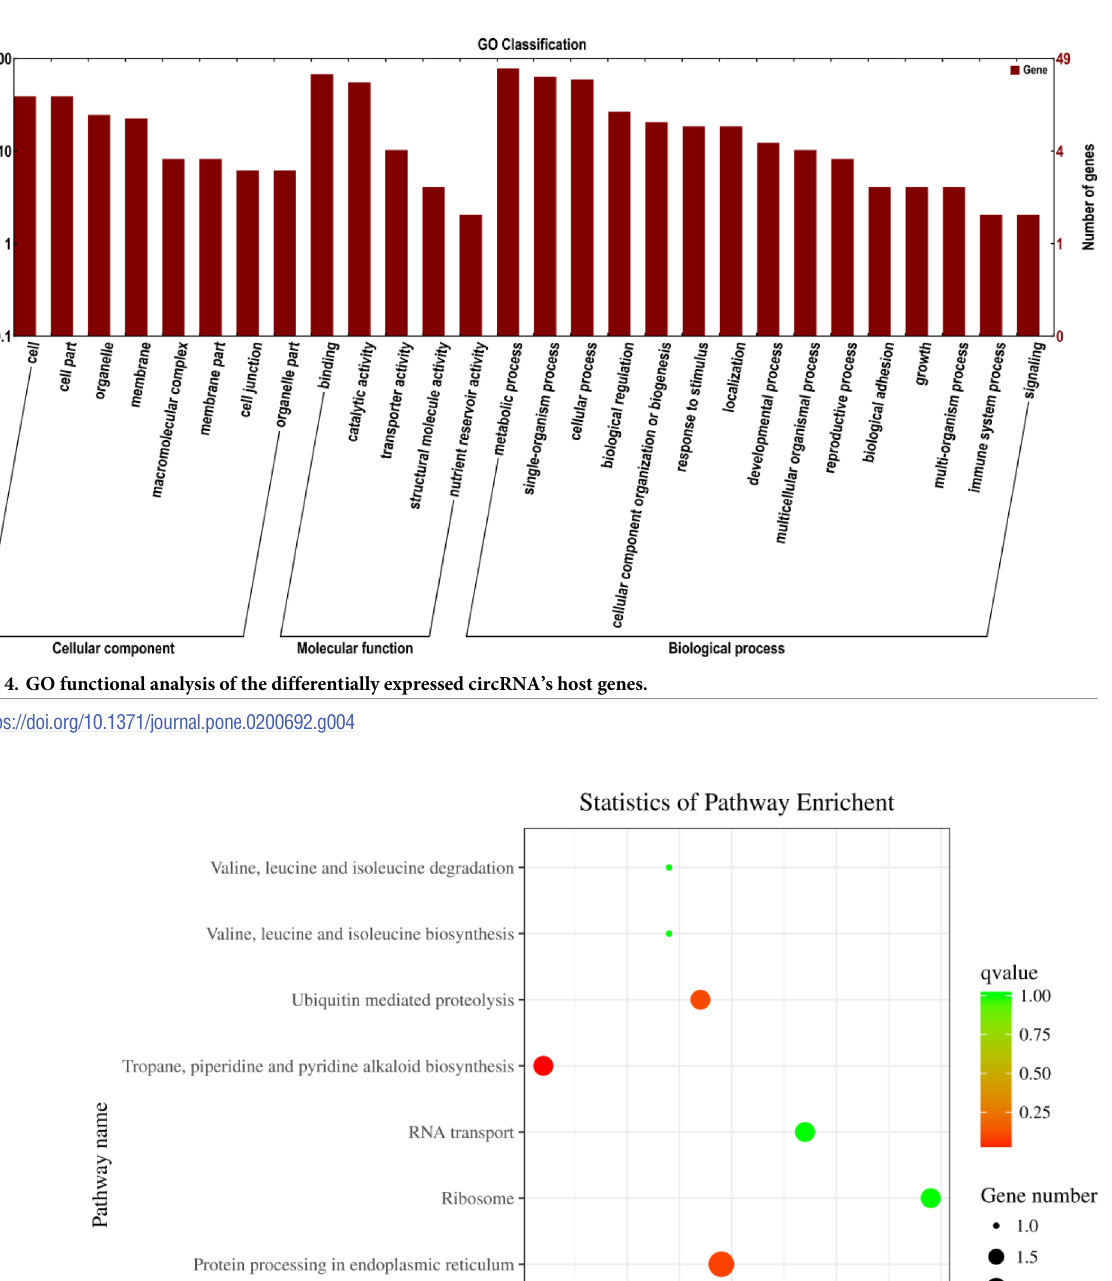
PLOS ONE | https://doi.org/10.1371/journal.pone.0200692 July 17,